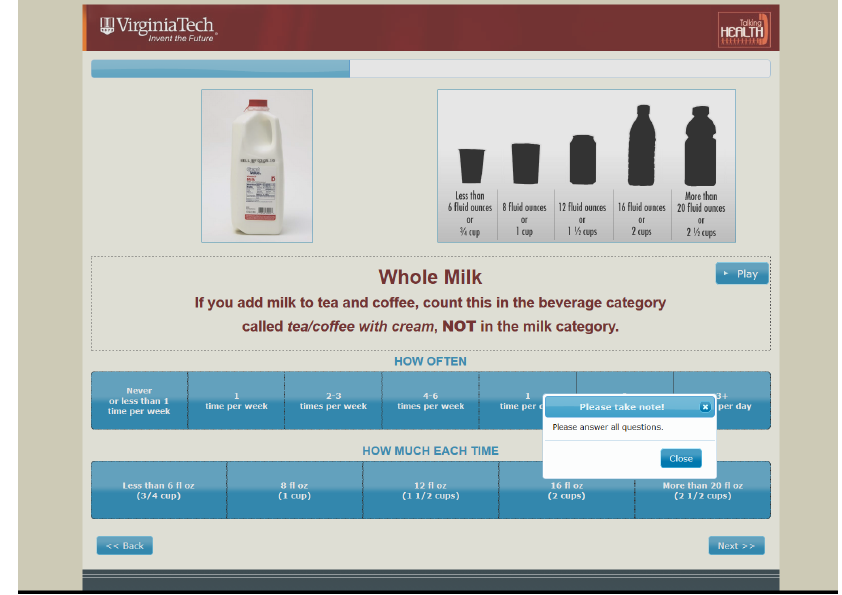
Figure 2. Screenshot example of attempting to move to the next beverage category without first